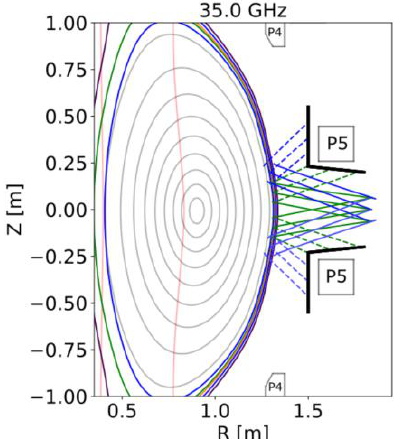
Fig. 9. A schematic plot of the poloidal cross-section of the beams from the midplane launcher for Ip = 800kA (green) and Ip = 2000 kA (blue). The dashed lines represent the beam reflected from the plasma after coupling. Thick black lines represent “interceptor plates” [1].